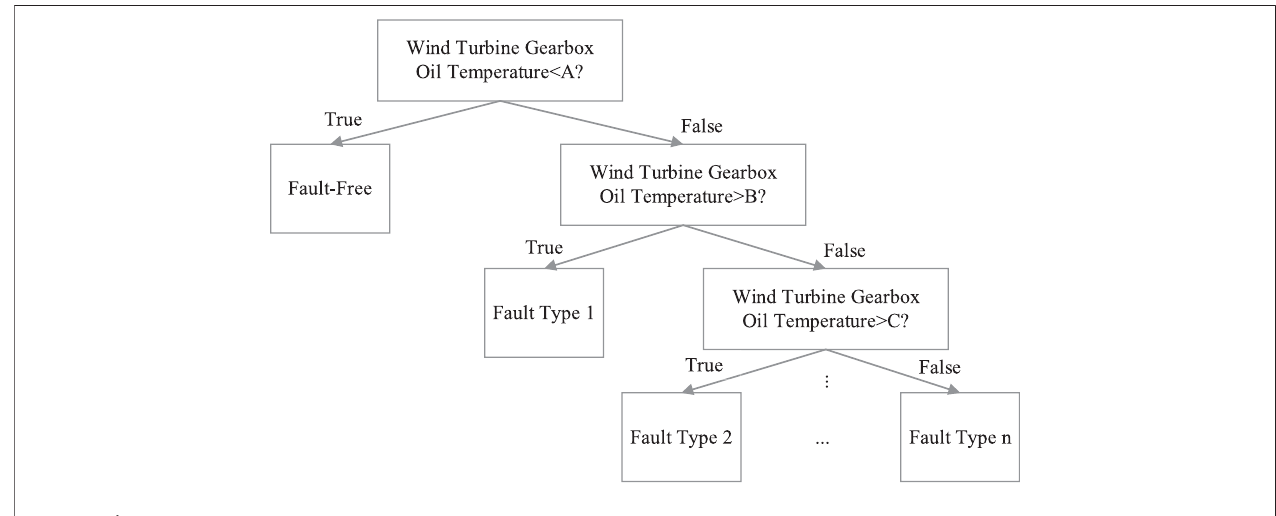
FIGURE 7 | WT fault diagnosis method based on decision